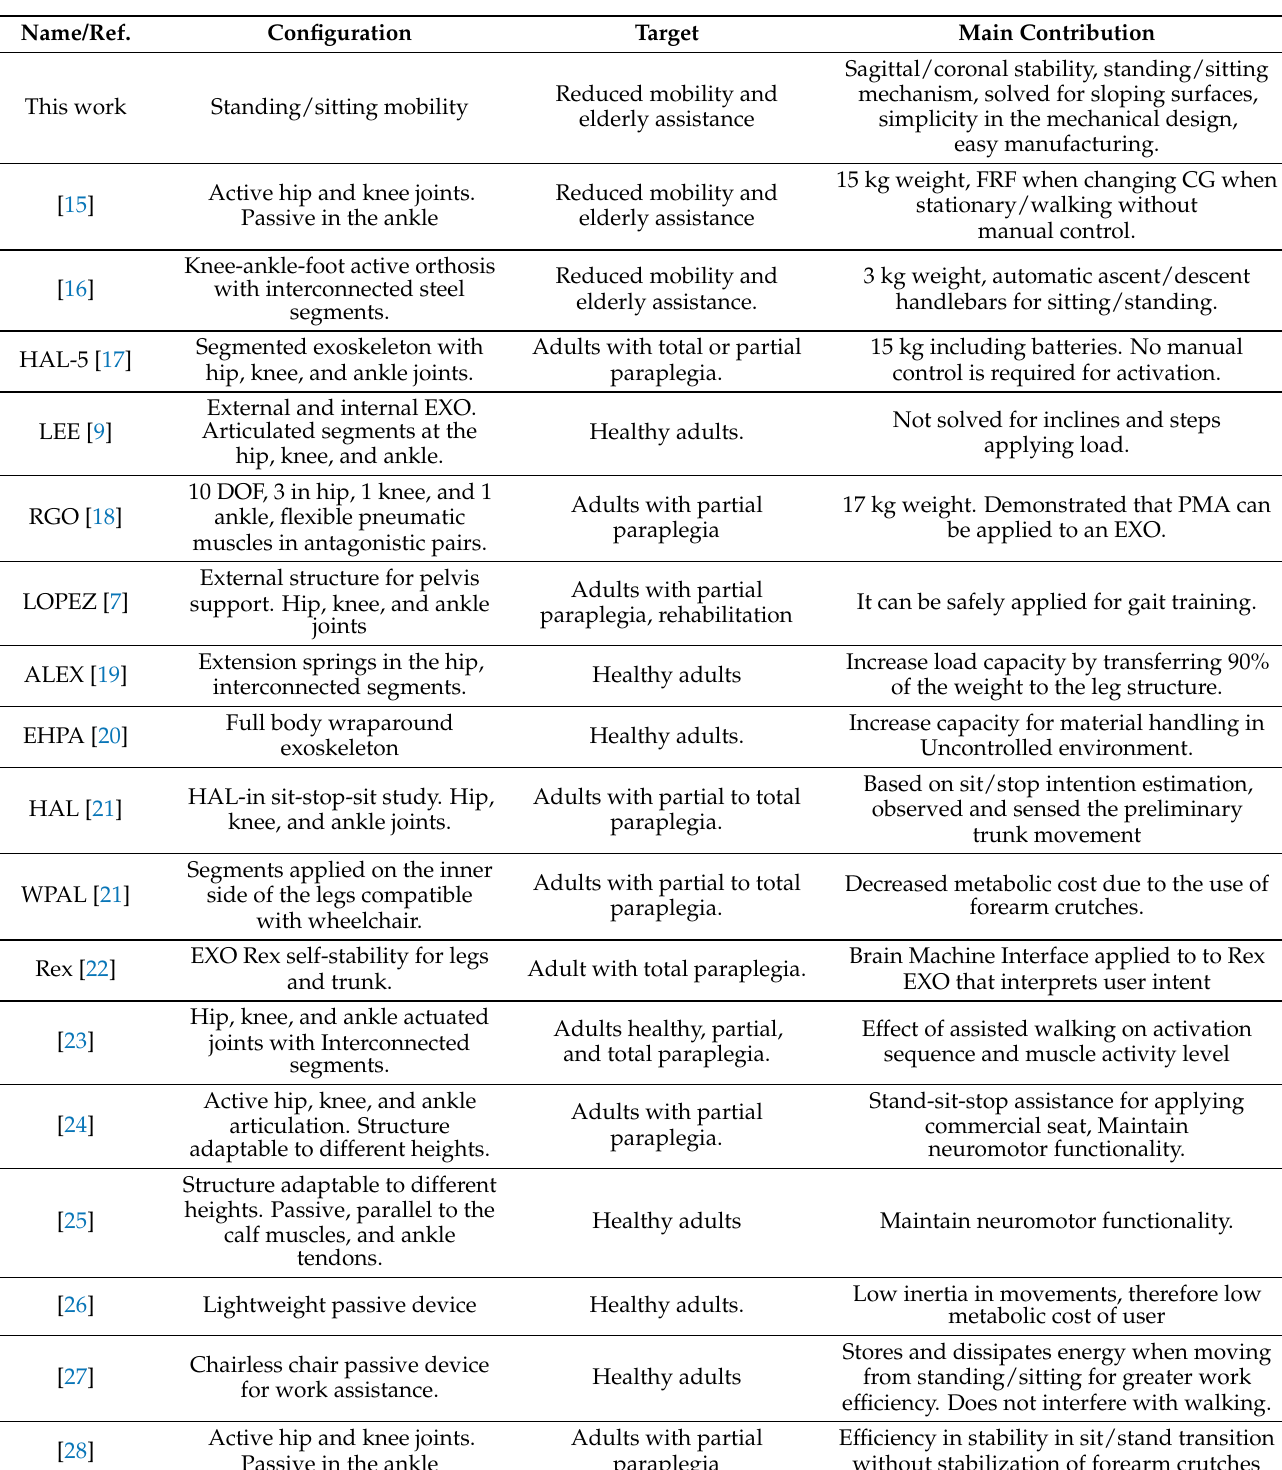
Table 6. Literature comparison with exoskeletons in the